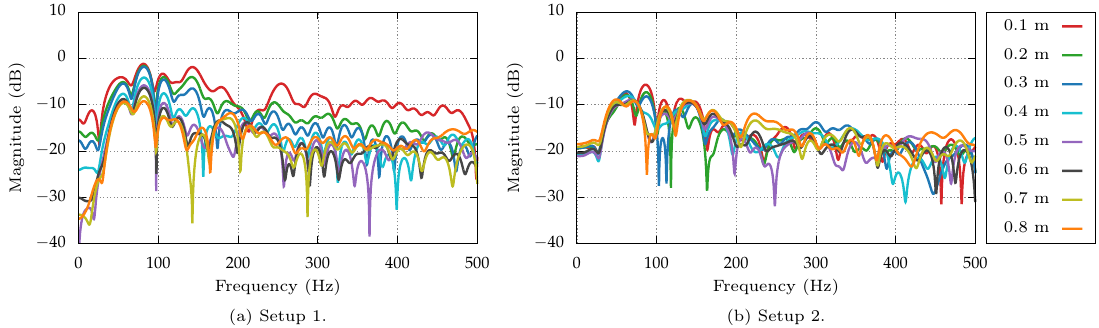
Figure 3. The amplitude functions of the frequency functions of the impulse response estimates for the primary paths with the error microphone adjacent to the right casing panel.